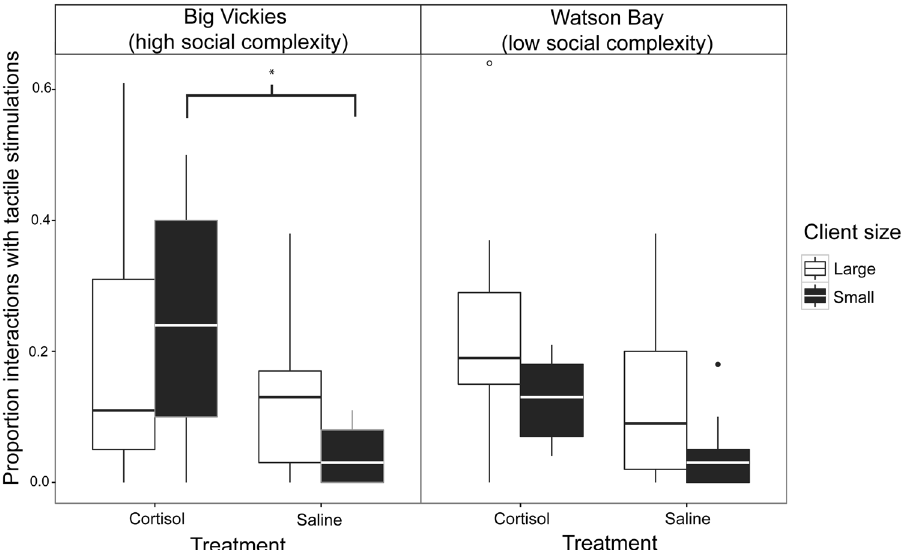
Figure 2. Proportion of interactions with client fish involving tactile stimulations. Boxplots (median and interquartile range) showing proportion of interactions with clients that included tactile stimulation for cleaner wrasse injected with cortisol or saline, at high (Big Vickies) or low (Watson Bay) social complexity sites, and interacting with large or small clients. See Figure S3 for model predictions and effects plots depicting the significant difference between the proportion of interactions with tactile stimulations given by cortisol and saline treated cleaners to small clients at high-complexity